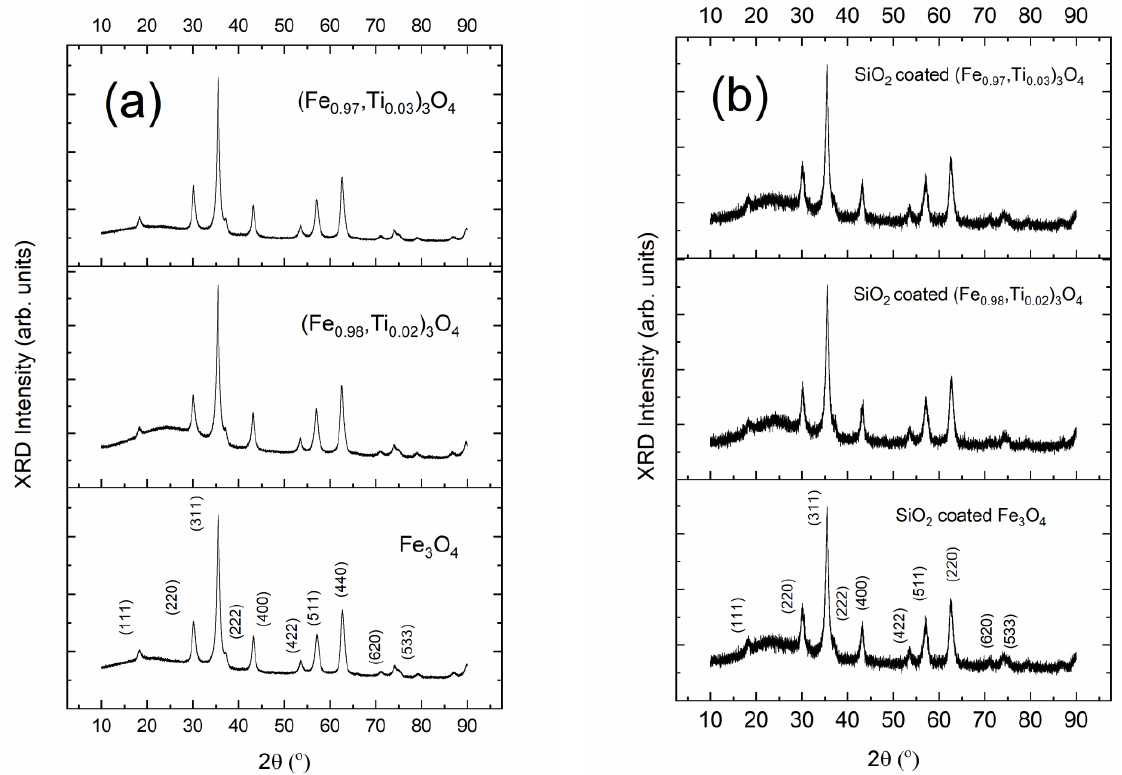
Figure 2. The XRD patterns of ( a ) Ti-doped magnetite and ( b ) SiO 2 coated Ti-doped magnetite.